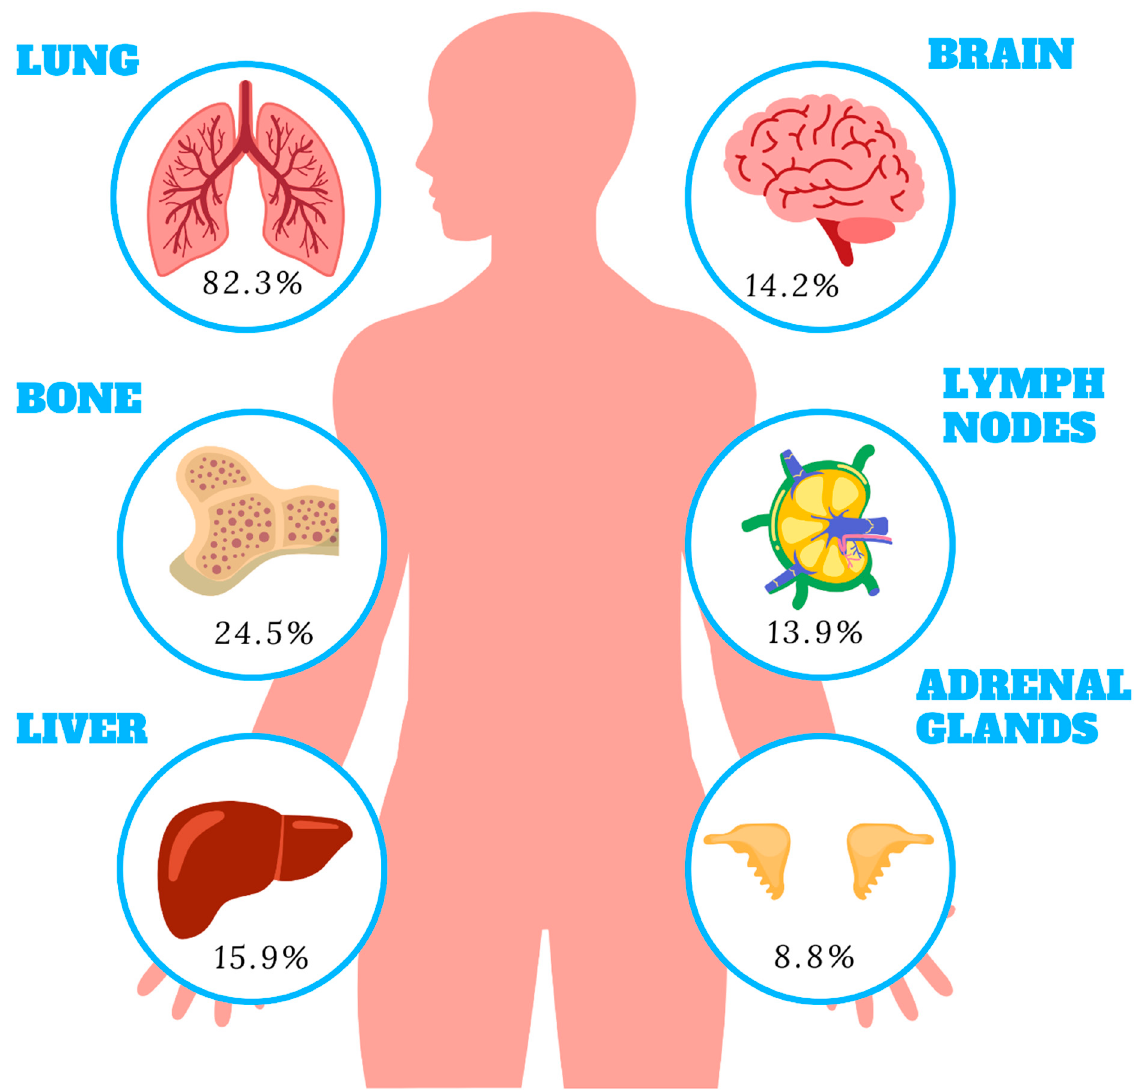
Figure 1. Most common sites of metastases in RCC.